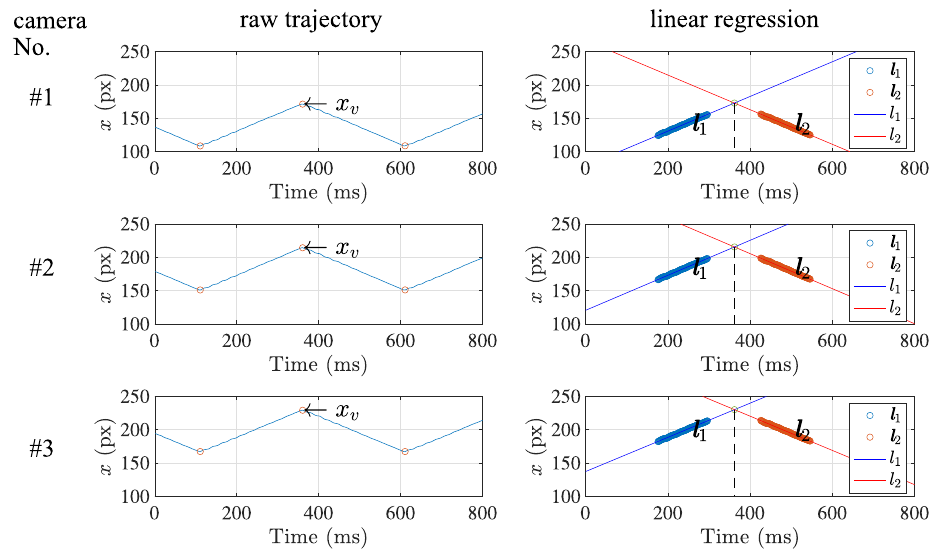
Figure 10. Accuracy of the estimated frame synchronization. The intersection of two adjacent linear section was calculated in sub-frame accuracy at each camera, which indicates the moment that the direction change of the light spot occurs.